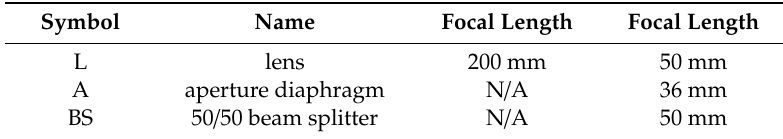
Table 2. Parameters of experimental